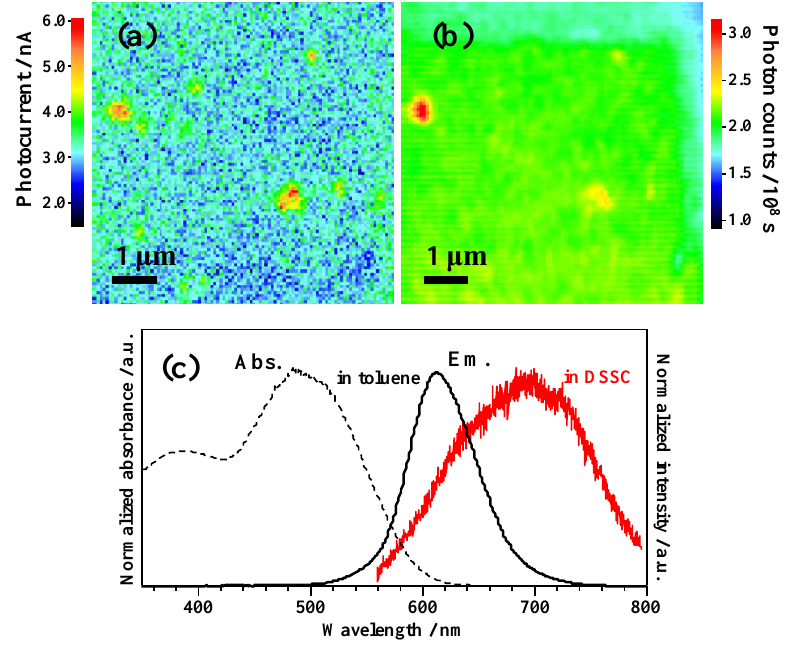
Figure 3. Examples of ( a ) PC and ( b ) PL images simultaneously recorded for the same area in a MK-2-DSSC device. ( c ) Absorption and PL spectra of MK-2 in toluene (black lines) and PL spectrum of MK-2 in the DSSC device (red line).